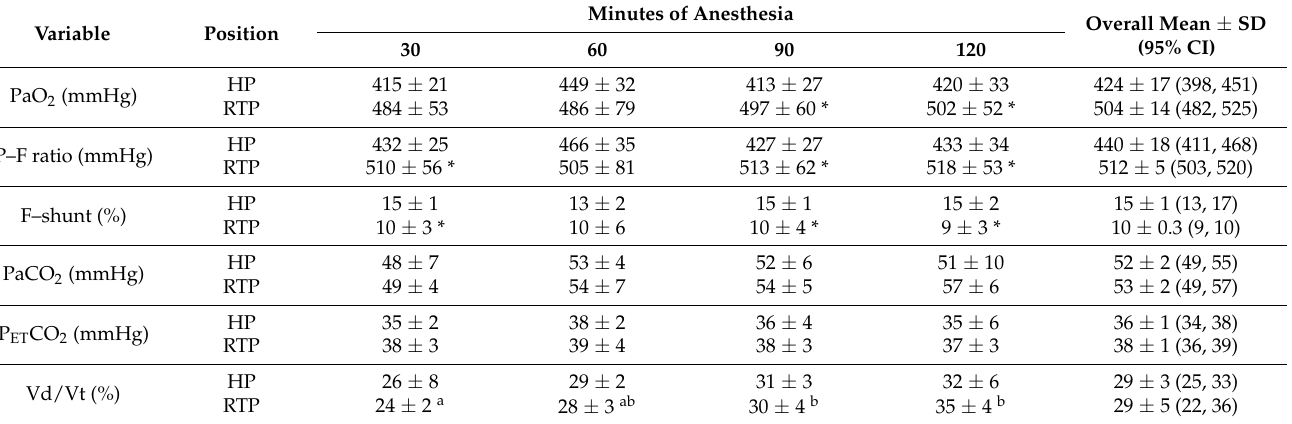
Table 2. Mean ± SD arterial partial pressures of oxygen (PaO 2 ), carbon dioxide (PaCO 2 ), end- tidal carbon dioxide (P ET CO 2 ), arterial-to-inspired oxygen ratio (P–F ratio), alveolar dead-space ventilation (Vd/Vt), and oxygen content-based index (F–shunt) in isoflurane-anesthetized, dorsally recumbent, mechanically ventilated horses ( n = 5) positioned either horizontally (HP) or in a 15 ◦ reverse Trendelenburg position (RTP). An asterisk indicates a significant difference ( p < 0.05) between treatment for each variable. Within treatment, differences are indicated with superscript letters (time points without a common letter are significantly different). Variables without notation were not significantly